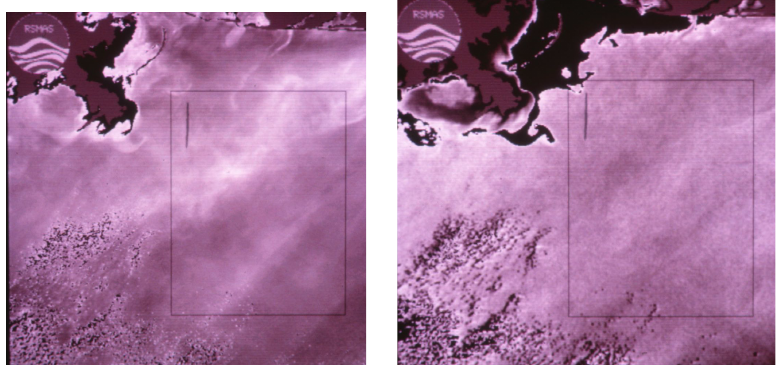
Figure 3. ( Left Panel ) Image of L a ( 670 ) = L t ( 670 ) − L r ( 670 ) from CZCS Orbit 130 over the Mis- sissippi Delta region. ( Right Panel ) Image of ε ( 520,670 ) from CZCS Orbit 130 over the Mississippi Delta region. (Taken from [11]).